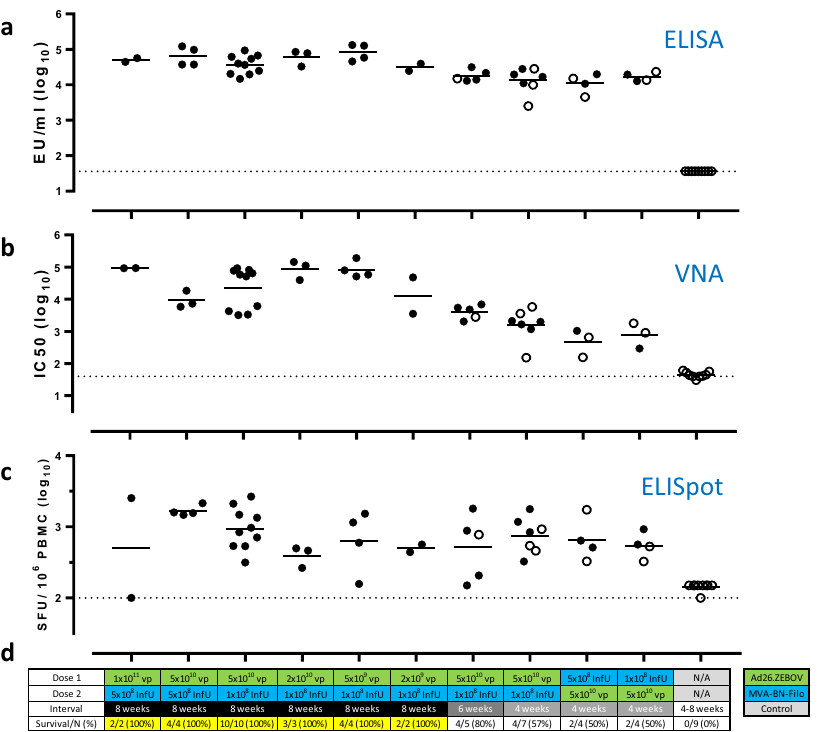
Fig. 2 Immunogenicity and protective ef fi cacy of Ad26.ZEBOV, MVA-BN-Filo regimens in NHP. Nonsurviving NHP are depicted by open circles. a EBOV GP-binding antibody concentrations (ELISA units [EU]/mL, log 10 transformed) by regimen as determined by Filovirus Animal Non-Clinical Group (FANG) EBOV GP ELISA (BBRC); group means are indicated; samples below the lower limit of detection (LOD) are plotted at a common value (dotted line). b EBOV neutralizing antibody titers (IC 50 , log 10 transformed) as determined by pseudovirus neutralization assay (psVNA; Monogram); group means are indicated; dotted line is LOD. Three samples could not be analyzed due to sample volume limitations. c EBOV GP-reactive IFN- γ T cells (spot-forming units [SFU]/10 6 cells, log 10 transformed) as enumerated by IFN- γ ELISpot (TBRI); group means are indicated; samples below LOD are plotted at a common value (dotted line). d Table shows vaccine dose, dose order, and dose interval, as well as the associated survival after challenge. Additional regimens tested, as well as an overview by regimen can be found in Supplementary Fig. 2 and Supplementary Table 1. Dose of Ad26.ZEBOV (green) and MVA-BN-Filo (blue) as well as dose interval (shades of red and pink). Yellow shading identi fi es regimens with 100% protection. ELISA enzyme-linked immunosorbent assay, IFN- γ ELISpot interferon-gamma enzyme- linked immunospot, EU ELISA units, IC 50 half-maximal inhibitory concentration, InfU infectious units, LOD limit of detection, psVNA pseudovirus neutralization assay, SFU spot-forming units, PBMC peripheral blood mononuclear cells, vp viral neutralizing (Fig. 2b) antibodies. Based on GP-reactive T cells, as measured by interferon-gamma enzyme-linked immunospot (IFN- γ